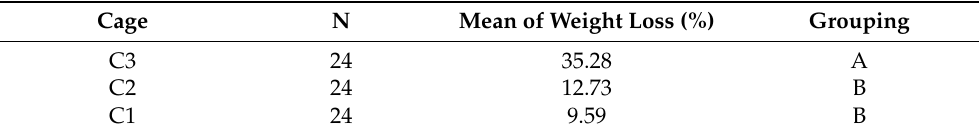
Table 6. Grouping information of cage using the Tukey method and 95% confidence.